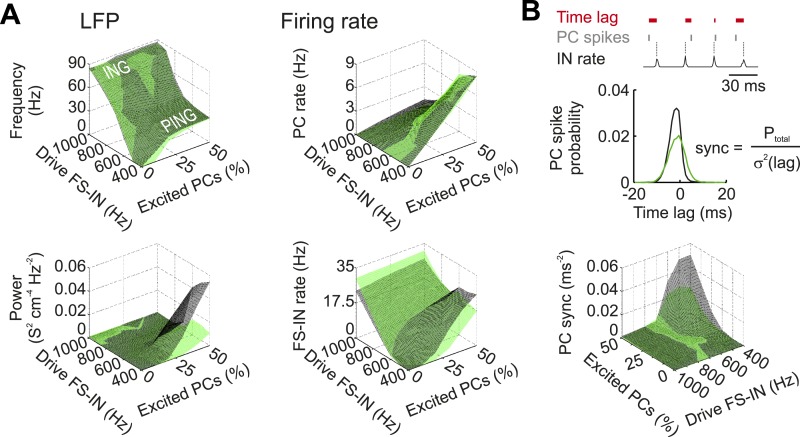
Characteristics of Disc1 and control low-gamma oscillations at different excitatory drives.(A) Control (black) and Disc1 (green) network activity was quantified by means of the LFP (left) and the average discharge rate (right) at different excitation strengths. Excitatory drive was modelled as Poisson-distributed excitatory postsynaptic conductances. A variable fraction of the PC population (0–50%) received excitatory inputs at 0.6 kHz. In contrast, 80% of the FS-INs were excited at varying mean frequencies (0.4–1 kHz). Top left, during conditions of strong excitation of FS-INs and weak excitation of PCs, oscillation frequency was high (>60 Hz) because FS-INs were highly active and PCs were silent. This corresponds to a gamma rhythm mediated by a network of mutually connected FS-INs (interneuron gamma (ING)-mechanism). Shifting the excitation away from the FS-INs and recruiting more PCs reduced the oscillation frequency and established a gamma rhythm mediated by recurrent PC-IN connections (pyramidal-interneuron gamma (PING)-mechanism). Bottom left, highest power of gamma activity was observed in the PING regime, where most of the analysis was performed (see Figure 5C–E). (B) Top, schematic illustrating the PC sync measure as a quantification of PC spike timing relative to FS-IN activity (‘Materials and methods’). Bottom, in the PING regime (high PC drive, low FS-IN drive), PCs in the control network display much higher spike time fidelity than Disc1 PCs.